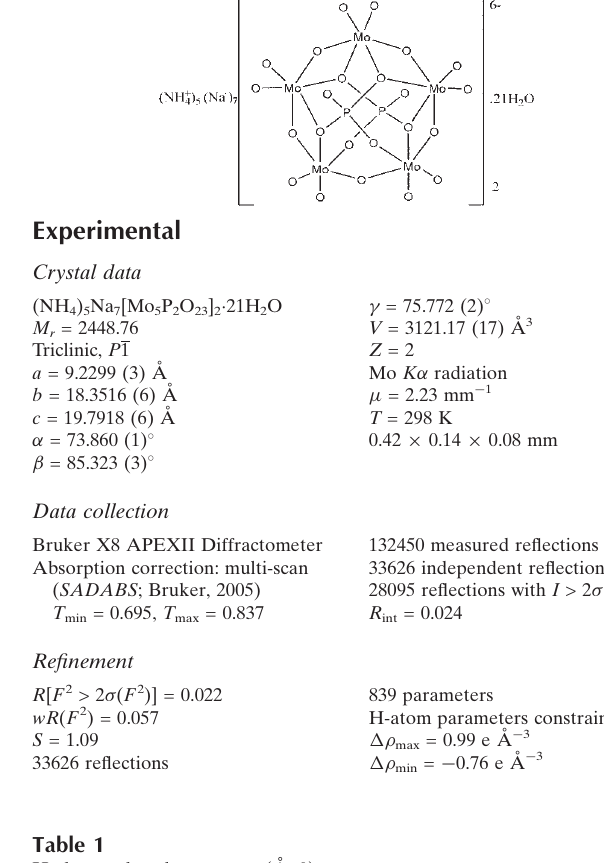
Hydrogen-bond geometry (A˚ , (cid:4)